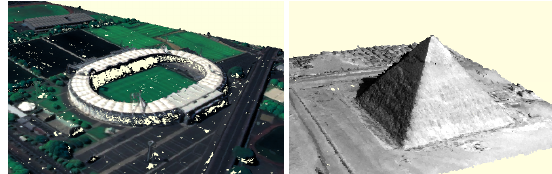
Figure 1: 3D point clouds automatically generated from Pléiades stereo datasets, without any manual intervention, with the s2p stereo pipeline. Its implementation can be tested online through a web